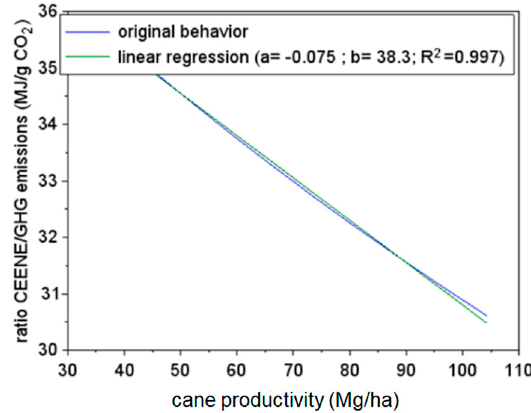
Figure 10. Y function behavior for sugarcane productivity (50% to 150%).